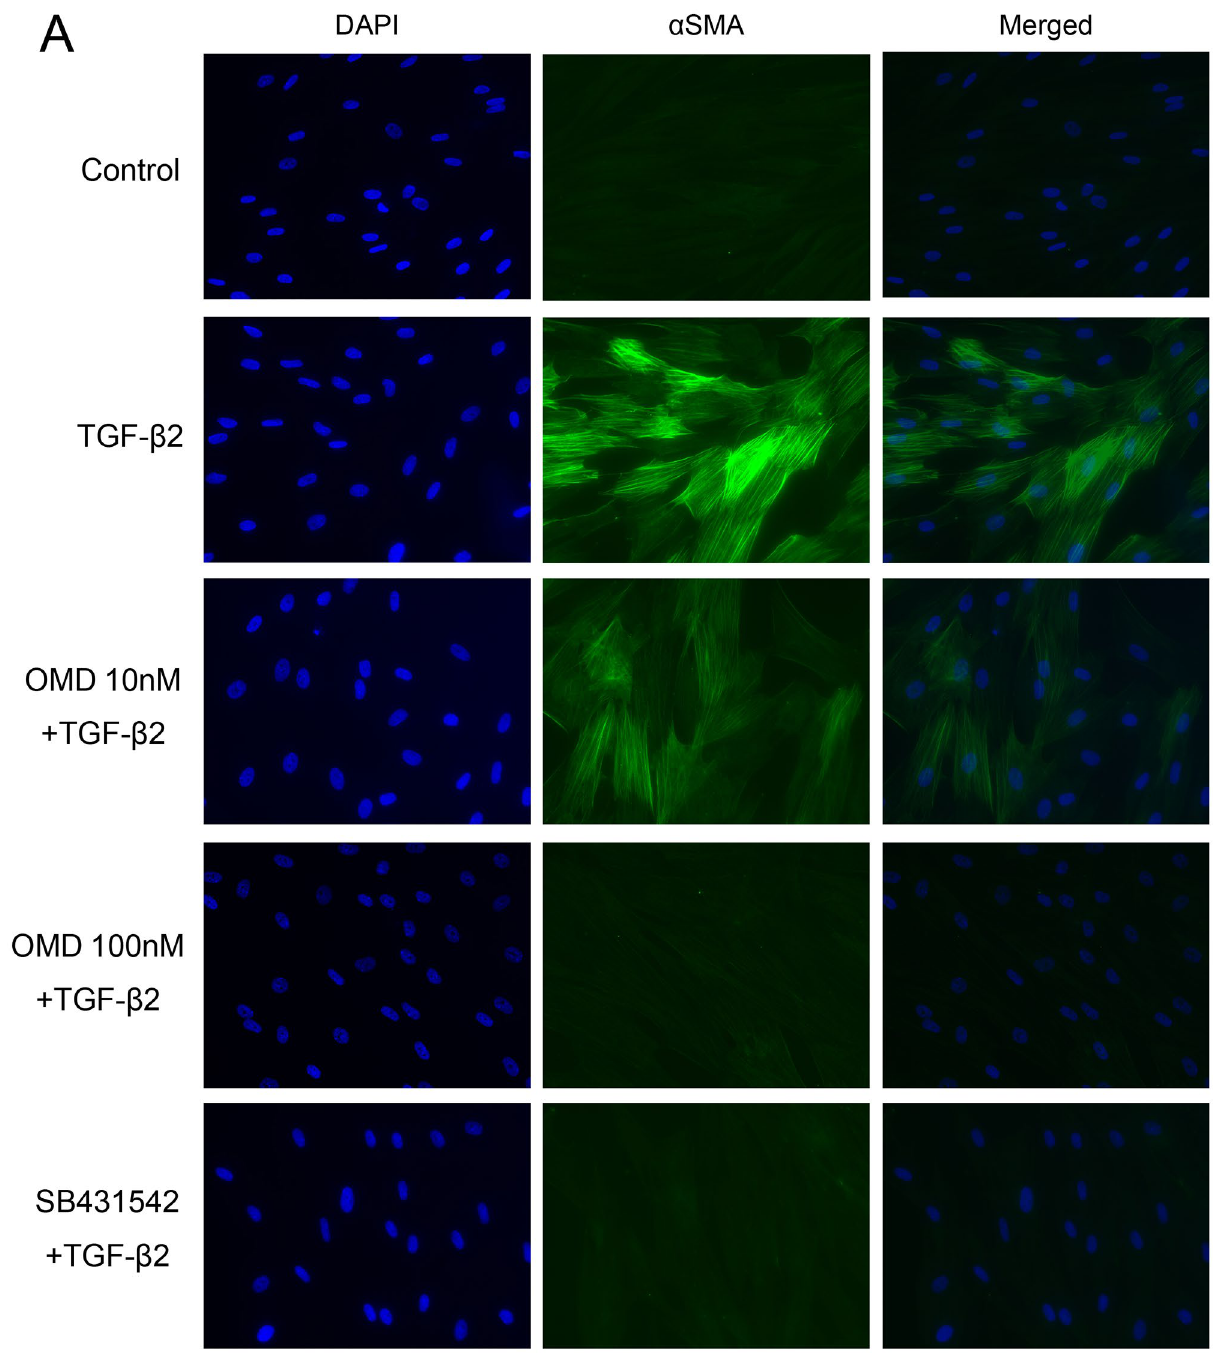
Figure 2. Effects of OMD on cytoskeletal and fibrotic protein expression in HTM cells. The effects of OMD on TGF-β2-induced cytoskeletal and fibrotic changes in HTM cells at 24 h were evaluated using immunocytochemistry. The samples were pretreated with TGF-β2 for 72 h and then treated simultaneously with TGF-β2 and OMD and fixed at 24 h after the stimulation with OMD. The left panels show cell nuclei counterstained with 4 ′ ,6-diamidino-2-phenylindole (DAPI; blue). The middle panels show cells stained for αSMA (green, A ), COL1A (green, B ), FN (red, C ), and F-actin (red, D ). The right panels show merged images. TGF-β2 significantly induced cytoskeletal and fibrotic changes in HTM cells and these changes were significantly suppressed by treatment with 100 nM OMD. Scale bars: 50